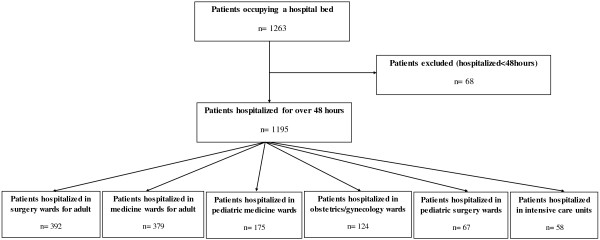
Flow-chart of the patients included in the study and hospitalization wards at the day of survey.